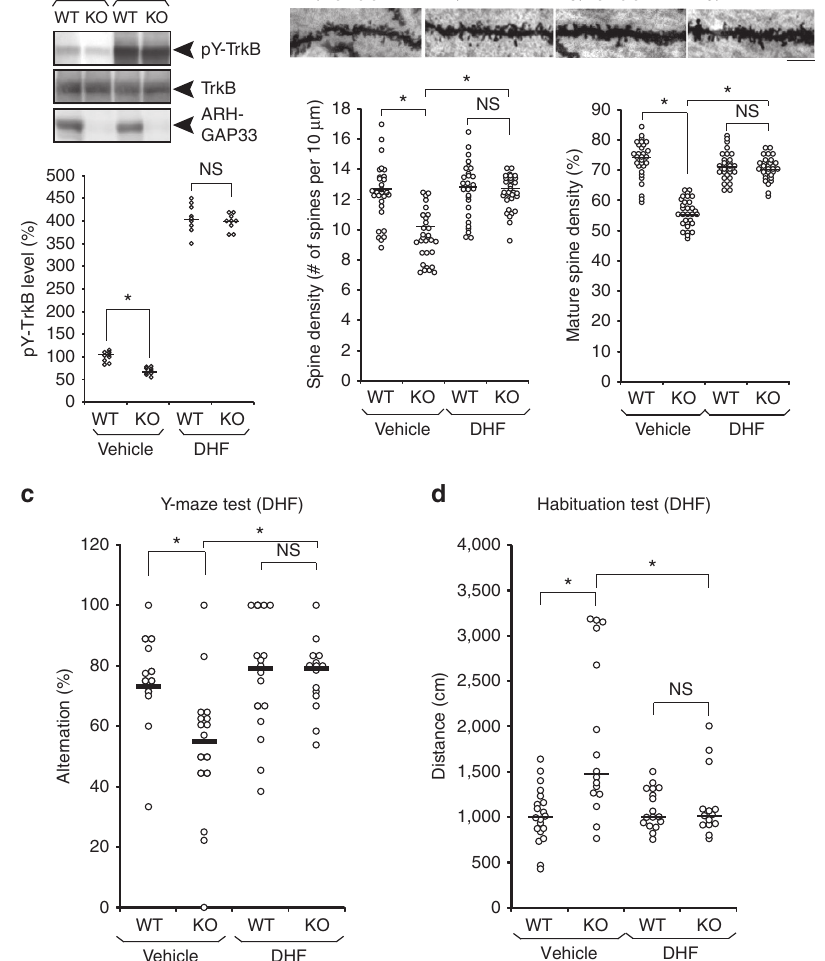
Figure 4 | Rescue of the impaired spine development and behavioural abnormalities in ARHGAP33 KO mice via TrkB activation in adulthood. ( a ) Activation of TrkB by 7,8-DHF injection (12.5mgkg (cid:3) 1 ). TrkB-immunoprecipitates and hippocampal lysates were immunoblotted with the indicated antibodies. Representative blots (upper) and quantification of phospho-TrkB levels (lower; each n ¼ 9, corrected P ¼ 0.0014, Mann–Whitney U -test with the Ryan’s correction). The pY-TrkB levels of vehicle-KO, DHF-WTand DHF-KO were normalized to that of vehicle-WT (The averaged vehicle-WT